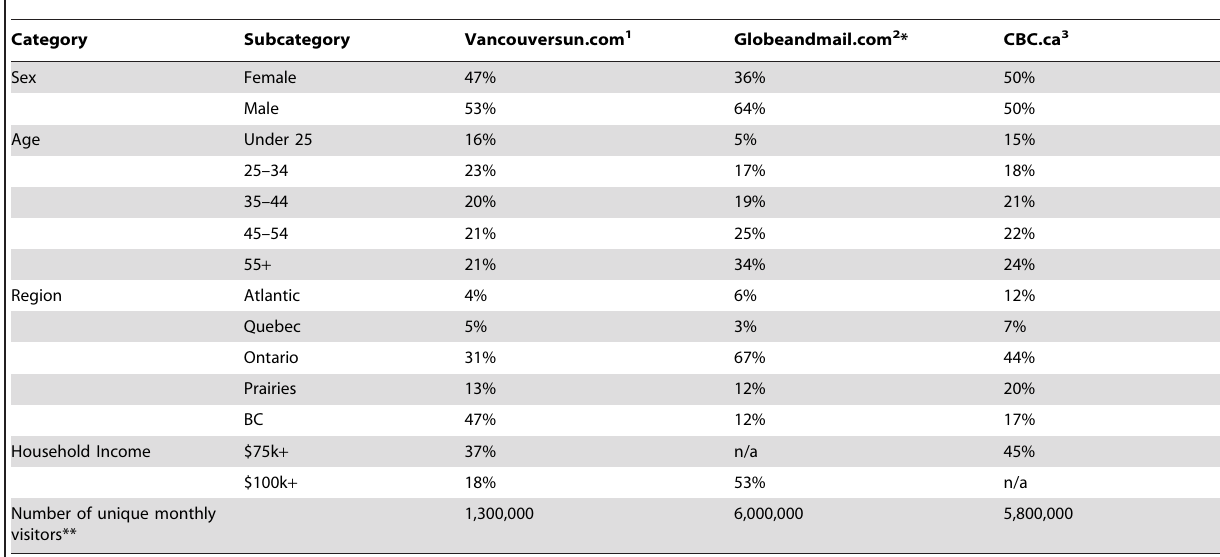
Table 1. Reader profile for vancouversun.com, globeandmail.com and